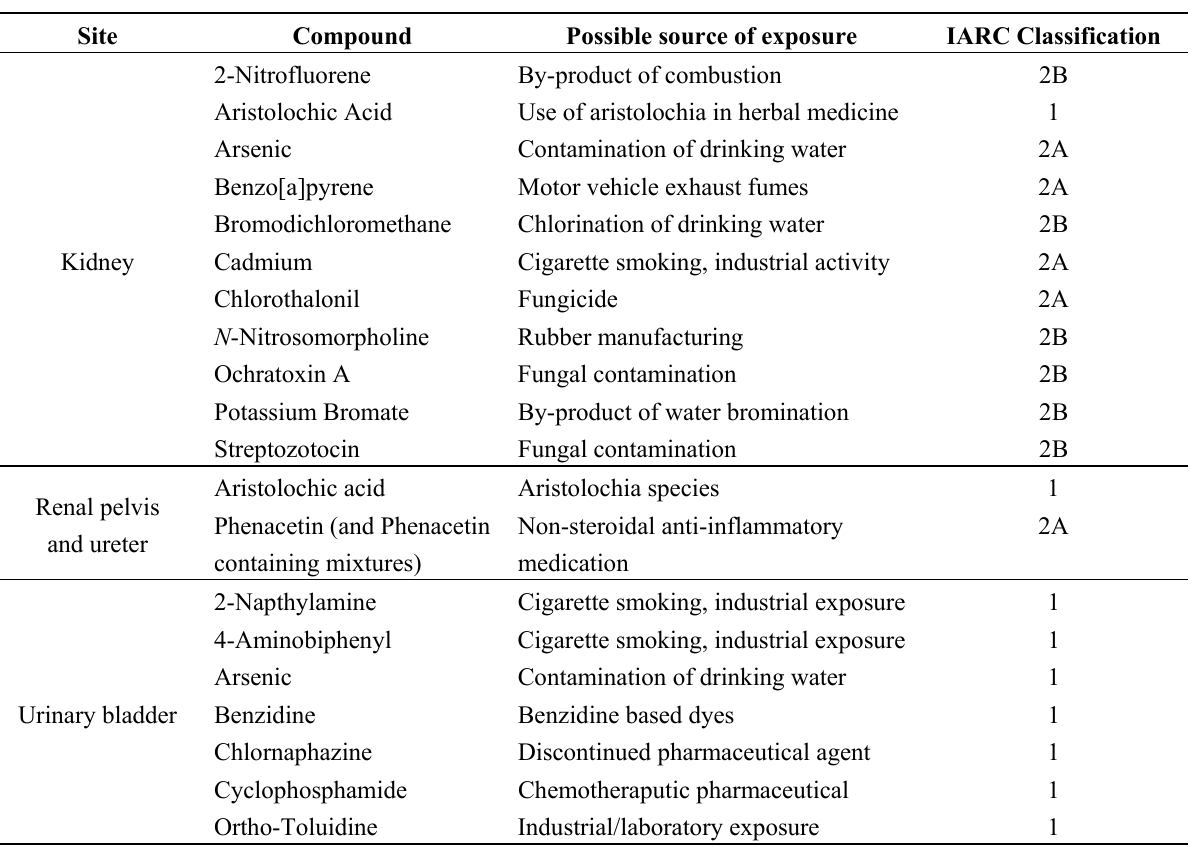
Table 1. IARC carcinogen classification for compounds affecting the renal and urinary system: Several examples of chemical substances which are either known or suspected to induce cancers of the kidney and urinary system. IARC grouping: Class 1—known to cause cancer in humans, Class 2A—probably carcinogenic to humans, Class 2B—possibly carcinogenic to humans, Class 3—not found to be carcinogenic to